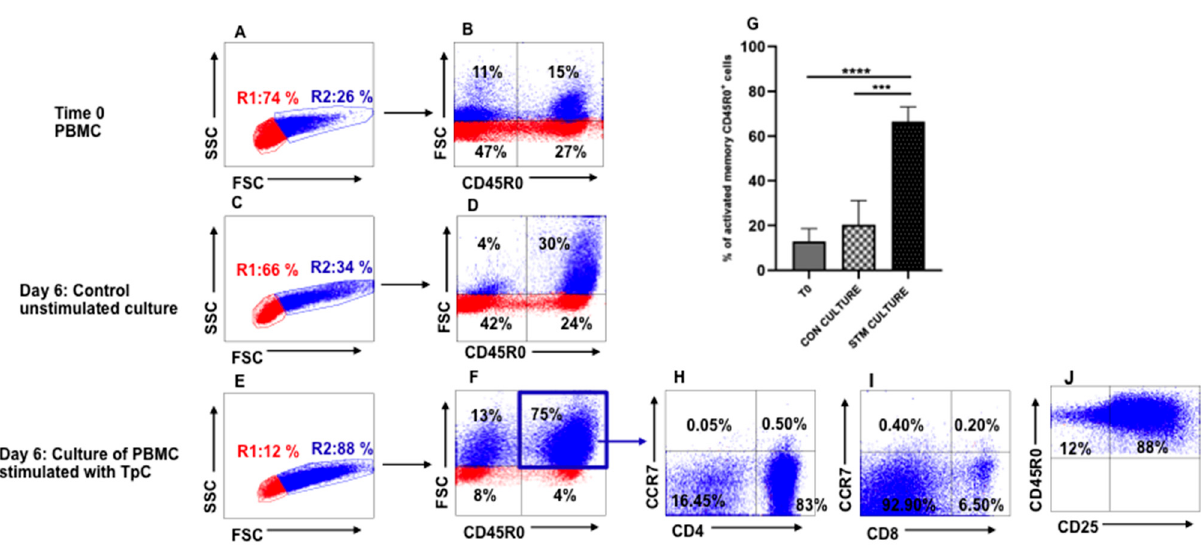
Figure 1. Analysis of the proliferative T-cell response to stimulation with autologous, irradiated, T. parva -infected cell lines (infected cell lines). Illustration of selective gating and the color coding strategy used to identify and track proliferation and expansion of antigen-specific memory T cells based on size increase of cells undergoing blastogenesis. Gate R1 distinguishes small, non-proliferating, resting lymphocytes and gate R2 distinguishes proliferating cells of increased size. An additional gate was used to isolate and quantify the frequency of antigen-specific memory T cells proliferating in response to stimulation with infected cell lines, displayed in FSC vs. CD45R0. Representative profiles showing the proportion of large memory cells present in PBMC at the initiation of culture ( A , B ) with PBMC cultured for six days without infected cell line stimulation ( C , D ), and cultured for six days with infected cell line stimulation ( E , F ) revealed an increase in antigen-specific memory T cells by six days of stimulation with infected cells. ( G ) Summary of the recall memory T-cell response of all four immunized steers to stimulation with autologous, irradiated infected cell lines. ( H , I ) Representative profiles showing the phenotype and frequency of memory CD4 + ( H ) and CD8 + ( I ) T cells proliferating in response to stimulation with infected cells lines. ( J ) Representative profile showing most of the antigen-specific proliferating memory T cells express CD25 by six days of stimulation with infected cell lines. CON CULTURE, unstimulated control culture; STM CULTURE, stimulated cultures. A one-tailed Student’s t -test was used to compare memory T cells present in unstimulated cultures at the initiation of culture (T0) with memory T cells present in unstimulated ( p < 0.0001, ***) and six-day infected-cell-line-stimulated cultures ( p = 0.0003,